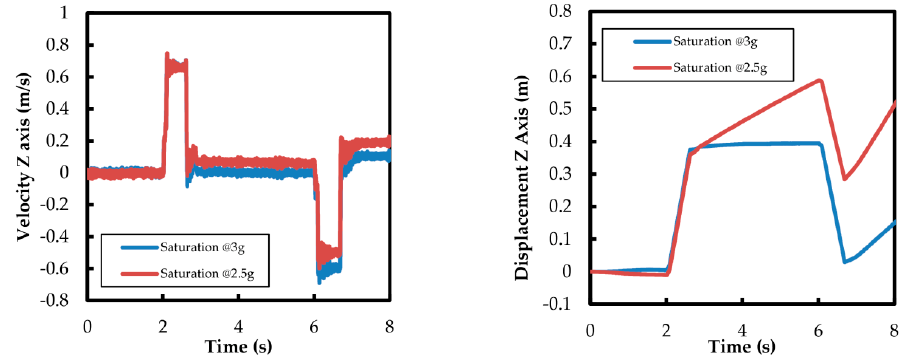
Figure 12. Calculated velocity and displacement for Z axis; Signal saturation error evaluation.